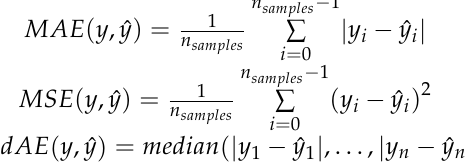
Figure 3. Spearman’s rank correlation for all datasets, for the various importance measures with the golden standard ranking.